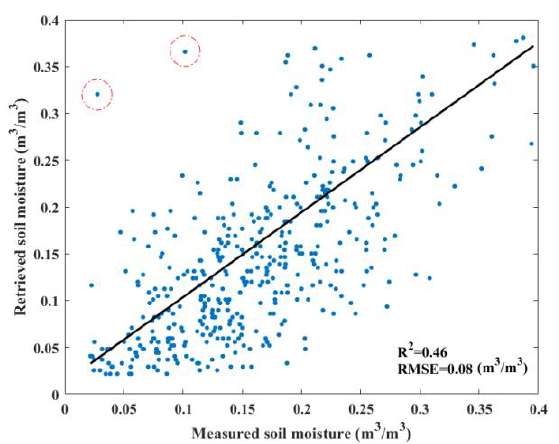
Figure 10. Scatterplots between measured and retrieved soil moisture for all stations.